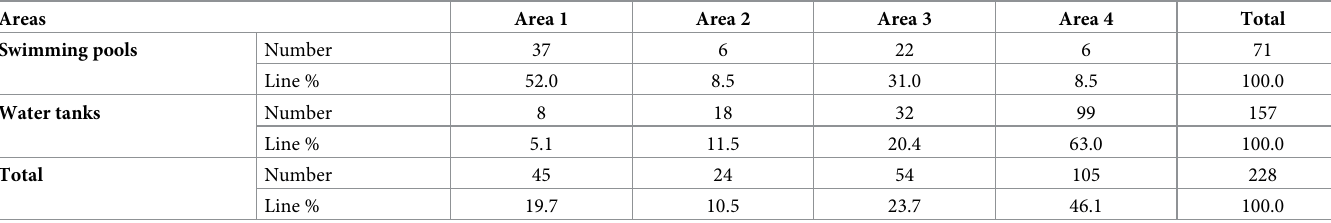
Table 4. Numbers of swimming pools and water tanks in the four study areas of Campinas.